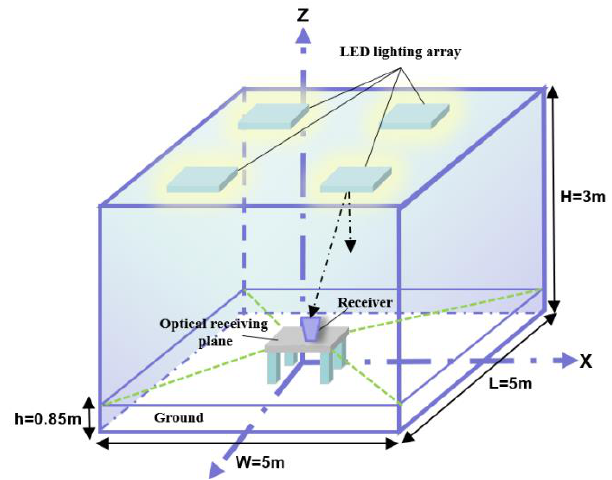
Figure 3. The communication model in the VLC